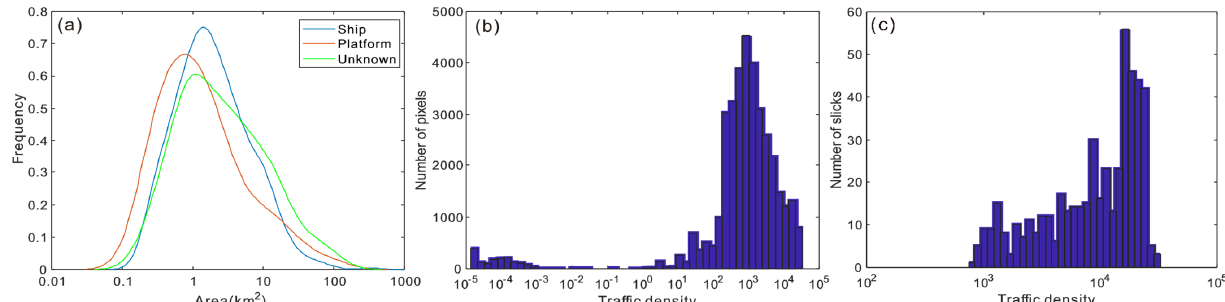
Figure 14. ( a ) The frequency distribution of slick areas from different sources; the frequency distri ‐ bution histogram of traffic density: ( b ) in the study area; and ( c ) in the slick regions of ship origins.